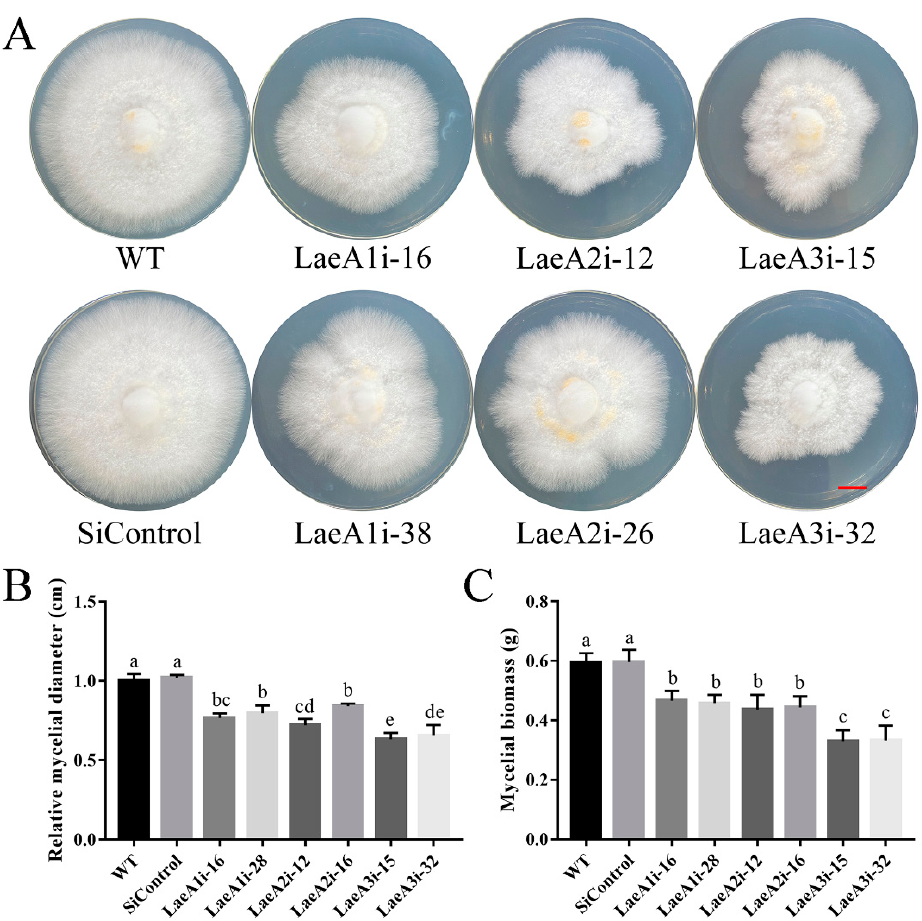
Figure 3. Hyphal growth and biomass of PoLaeA -silenced strains. ( A ) Fungal growth of P. ostreatus strains grown on CYM plates at 28 °C for 7 days. (Red scale bar = 1 cm). ( B ) Mycelial diameters. ( C ) Mycelial biomass. The values are the mean ± SD ( n = 3). Different lowercase letters indicate significant differences between the strains ( p < 0.05, according to Dunnett’s multiple comparisons test).